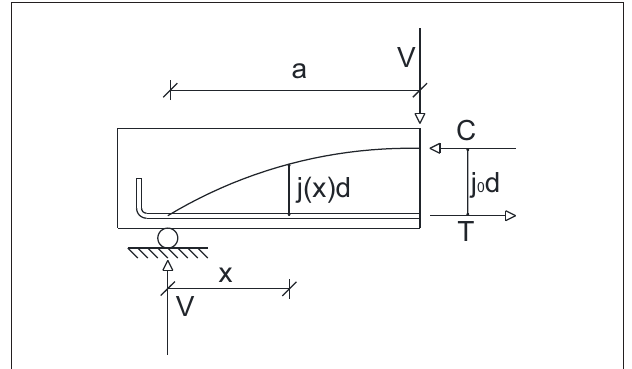
FIGURE 1 | Arch and beam